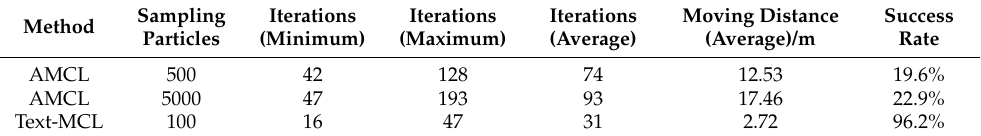
Table 3. Statistical data of three